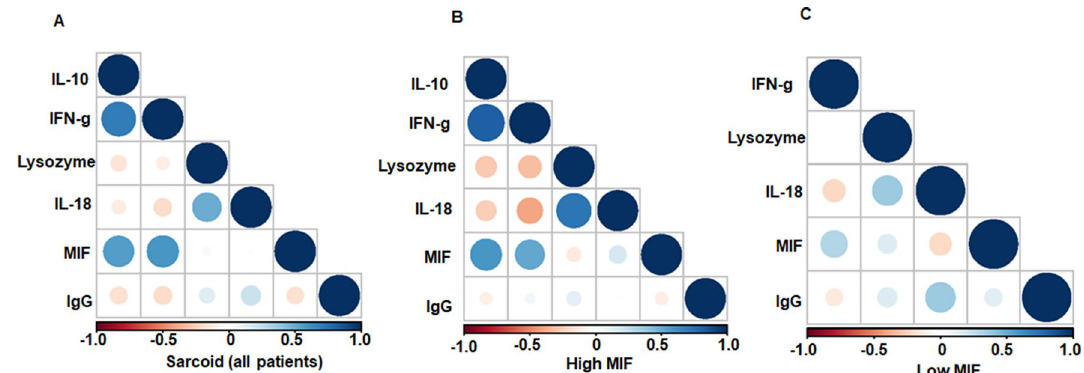
Figure 3. Correlation heatmap plots of serum cytokines and biomarkers in sarcoid patients. Correlation heatmaps of serum cytokines in sarcoid patients and low MIF and high MIF subgroup were made using statistical program R. The correlation and significance of mediators is depicted based on color (blue for positive correlation and pink for negative correlation) and size (larger depicts higher significance). Correlation heatmap of serum cytokines, IgG, and lysozyme among all sarcoidosis patients ( A ), high MIF subgroup ( B ) and low MIF subgroup ( C